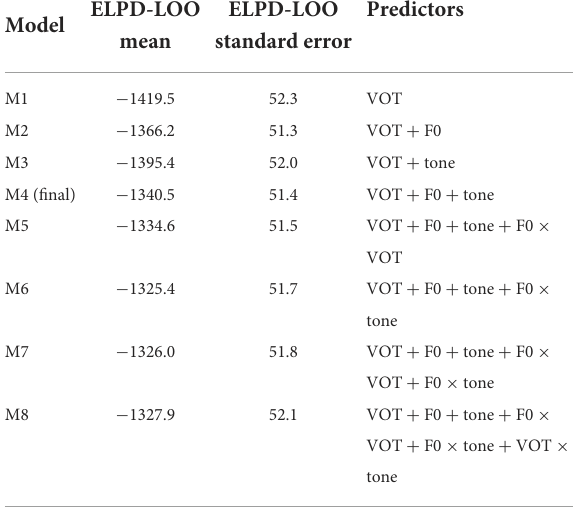
TABLE 4 Candidate perceptual models considered in model comparison, with their ELPD-LOO means and standard errors.